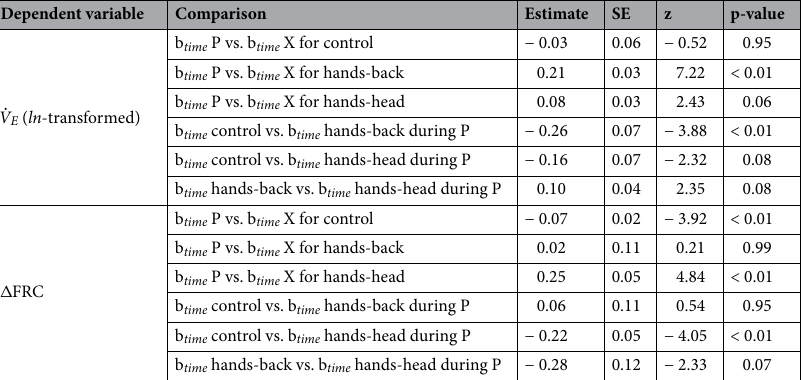
Table 7. Analysis of recovery in the unweighted prone phase. This analysis compares the slopes ( b time ) of parameters between the unweighted prone phase, P, and the previous weighted restraint phase, X 1 − 5 . Following ˙ V the removal of the weight, both E and (cid:31) FRC continued to decay with time during the 2 min comprising the ˙ V unweighted prone phase P. The recovery of E (i.e., its decrease with time) within the P was significantly faster in the control condition as compared to the hands-back treatment. Both restraint postures also slowed the ˙ V recovery of E in the P phase, as compared to the X phase. (cid:31) FRC continued to decline with time during the P phase. The exception was the hands-head posture, where (cid:31) FRC had a positive slope during the brief P phase. The analyses were mixed-effects regression models that account for a subject’s age, BMI, and experimental phase and treatment in the fixed effects, and include a random effect of subject identity to account for repeated measures (n = 1736 breaths from 17 subjects in the P and X phases). To appropriately model the variances, is ln-transformed, and the analysis for (cid:31) FRC accounts for unequal variance across